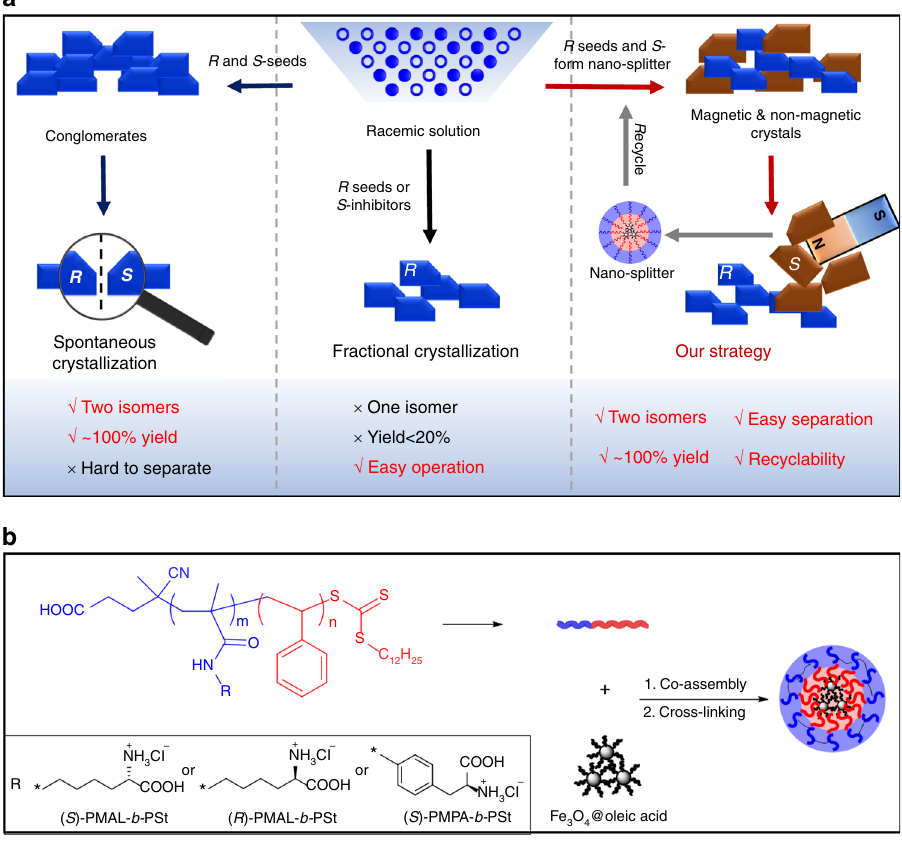
Fig. 1 Schematic of the magnetic separation system. a The concept of our strategy: in the spontaneous crystallization, two isomers with almost 100% yield can be obtained, but the enantiomeric crystals are hard to distinguish. In the fractional crystallization, only one isomer with less than 20% yield can be obtained in one crystallization process. In our strategy, the enantiomeric crystals can be easily separated by a magnetic fi eld with a quantitative yield. b The synthetic route of the